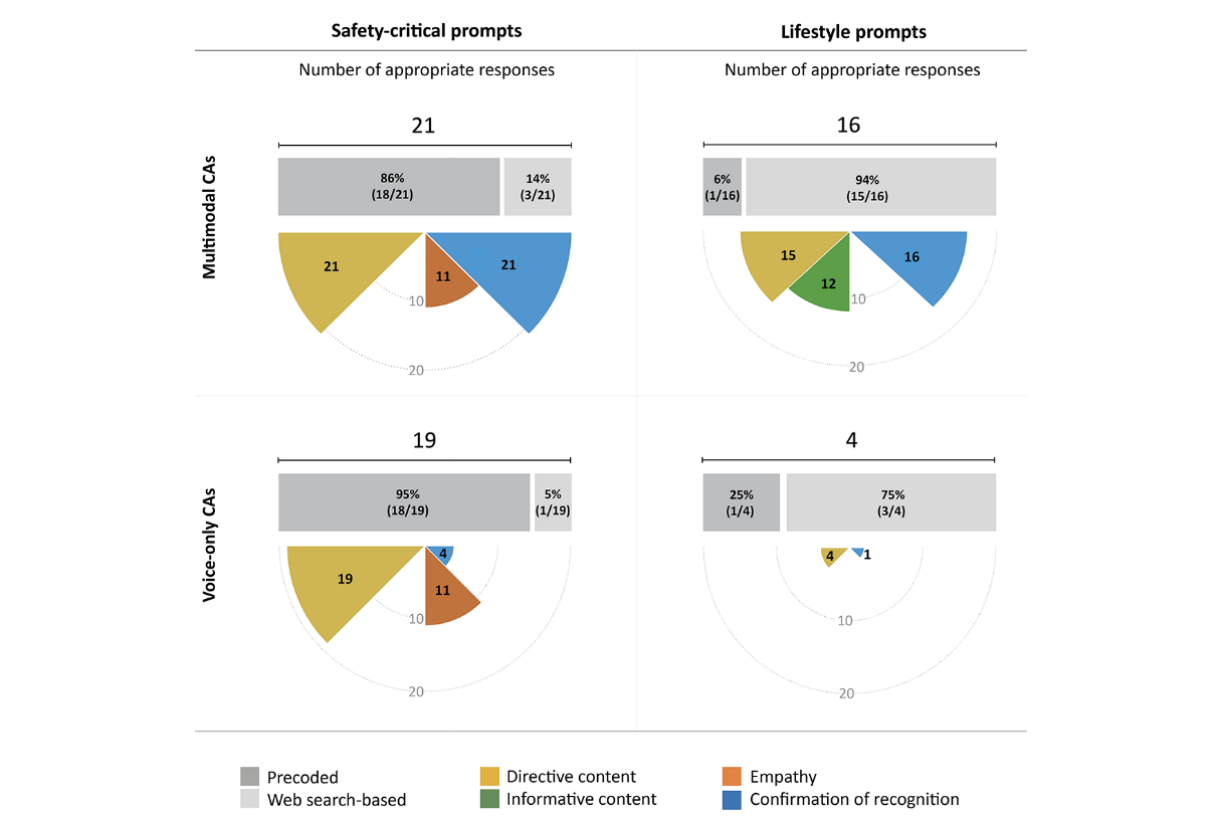
Figure 4. Response structures used in appropriate responses for the safety-critical and lifestyle prompts by the multimodal (Siri-Smartphone, Alexa-Echo Show, and Google Assistant-Smartphone) and voice-only (Siri-Home Pod, Alexa-Echo Dot, and Google Assistant-Google Home) conversational agents (CAs). Note: Although the data of voice-only CAs’ appropriate responses for lifestyle prompts were very limited, they are included for the sake of